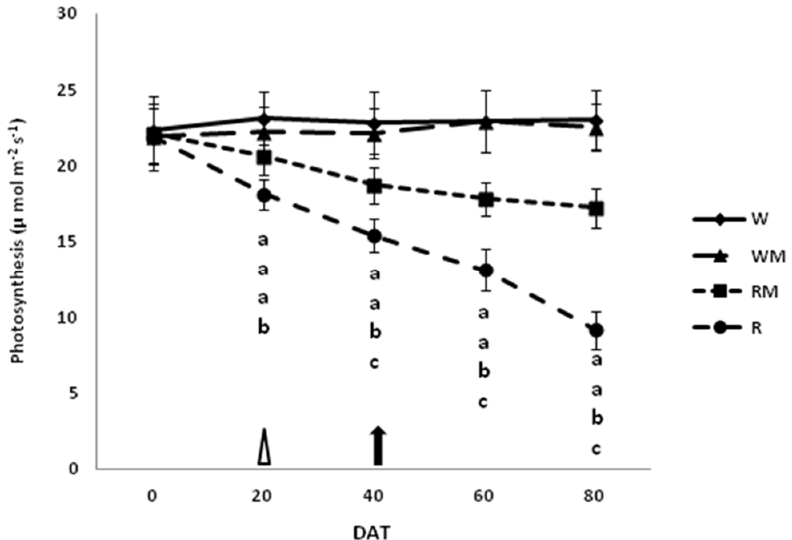
Figure 3. Changes in photosynthesis (µmol m − 2 s − 1 ) of spearmint exposed to the following treat- ments: R—rainfed without straw mulch, RM—rainfed with straw mulch, W—well-watered control plants and WM—well-watered with straw mulch. Measurements were performed 0, 20, 40, 60 and 80 days after the onset of the treatments (DAT). Vertical bars represent ± SE of the mean ( n = 5). Bars with different letters indicate significant differences among treatments in the given DAT at p ≤ 0.05. Triangle at 20 DAT indicates the early bloom, and arrow at 40 DAT indicates the full bloom, in overall treatments. The same trend was observed for stomatal conductance (Figure 4).